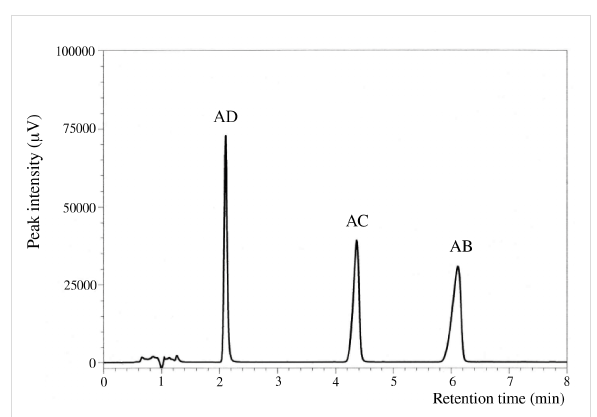
Figure 1: UFLC chromatogram of three regioismers of di-6- O -trityl- α - CD with 50% aqueous acetonitrile as an